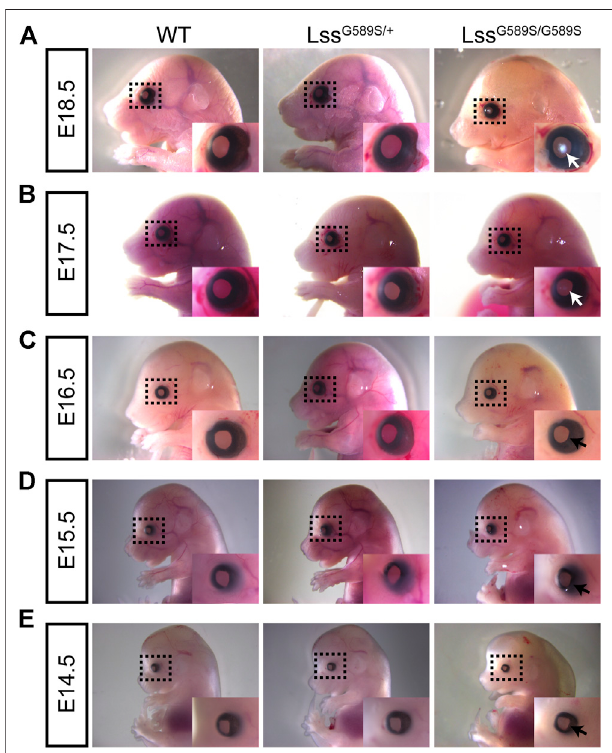
FIGURE 4 | Lens opacity caused by LssG589S/G589S mutation was formed at the embryonic stage. Examination of lens transparency in WT, Lss G589S/+ , and Lss G589S/G589S mice at (A) E18.5, (B) E17.5, (C) E16.5, (D) E15.5, and (E) E14.5 by stereomicroscopy. White arrows indicate that mild cataract was formed at E17.5 and serious cataract was formed at E18.5 in the lens of Lss G589S/G589S mice. Black arrows indicate that no visible cataract was observed at E14.5, E15.5, and E16.5 in the lens of Lss G589S/G589S